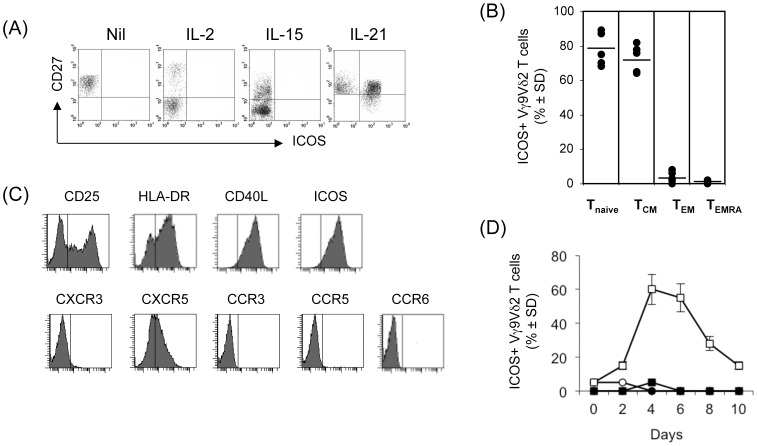
Surface phenotype of Vγ9Vδ2 T cells differentiated by antigen and IL-21.Vγ9Vδ2 T cells were primed for 12 days with an equal number of irradiated DCs and IPP, in the presence of IL-21. Cells were surface stained for several different markers. (A) shows CD27 and ICOS expression on Vγ9Vδ2 T cells that had been cultured with antigen alone (Nil) or with antigen but in the presence of IL-2, IL-15 or IL-21. Data are representative of seven independent experiments, each carried out in triplicate. (B) FACS analysis to determine the percentage of ICOS+ Vγ9Vδ2 T cells among highly purified TNaive,TCM, TEM and TEMRA subsets Vγ9Vδ2 T cells from eight different donors, primed with antigen and IL-21. Each symbol represents a single donor, small horizontal bars indicate the mean. In (C), expression of activation and costimulatory molecules, and chemokine receptors is shown upon gating on Vγ9Vδ2 T cells. The vertical line in each panel indicates the negative cut-off as determined by staining with isotype-control mAbs. (D) Time-course of ICOS expression on Vγ9Vδ2 T cells that had been cultured with medium alone (filled squares), with IL-21 alone (filled circles) or with antigen but in the absence (open circles) or presence (open squares) of IL-21. Data are representative of five independent experiments each carried out in triplicate.